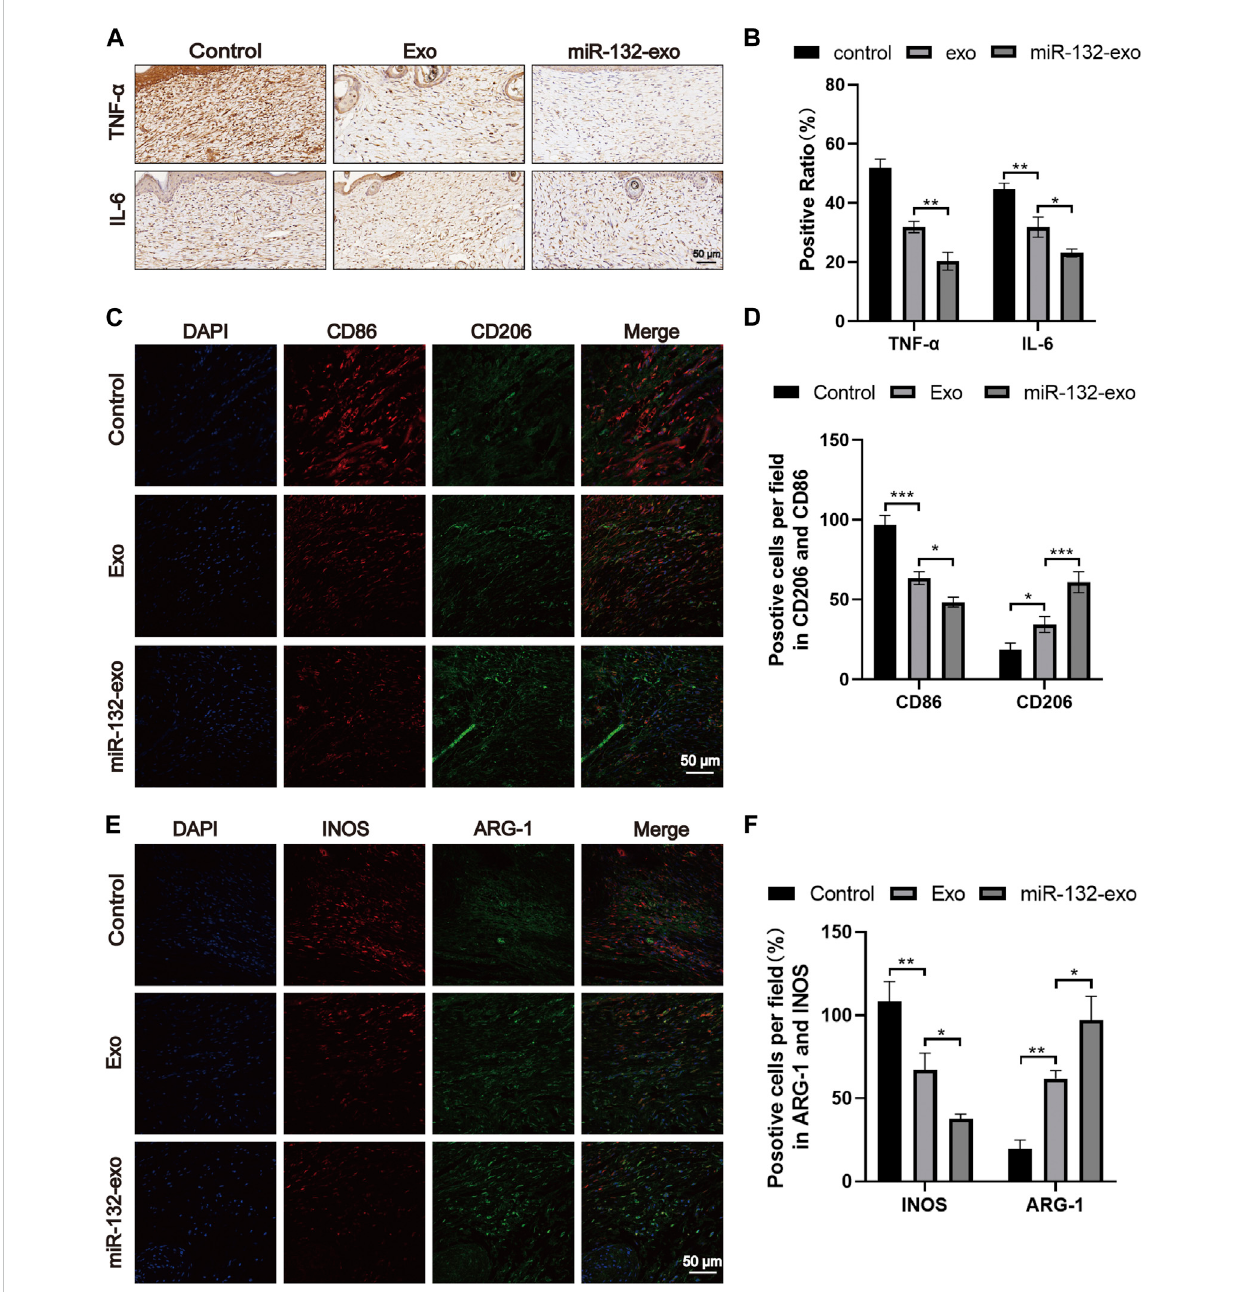
FIGURE 10 The miR-132-exo relieved in fl ammation and stimulated M2 polarization of macrophages in diabetic wounds. (A, B) Representative images (A) and positive staining ratio of immuostaining of TNF- α and IL-6 in each group on day 14, scale bar = 50 μ m; (C, D) Representative images and quanti fi cation analysis of co-staining of CD86 and CD206 in each group on day 14, scale bar = 50 μ m; (E, F) Representative images and quanti fi cation analysis of co- staining of INOS and ARG-1 in each group on day 14, scale bar = 50 μ m * p < 0.05, ** p < 0.01, *** p < 0.001, data are presented as the mean ± SD, n =